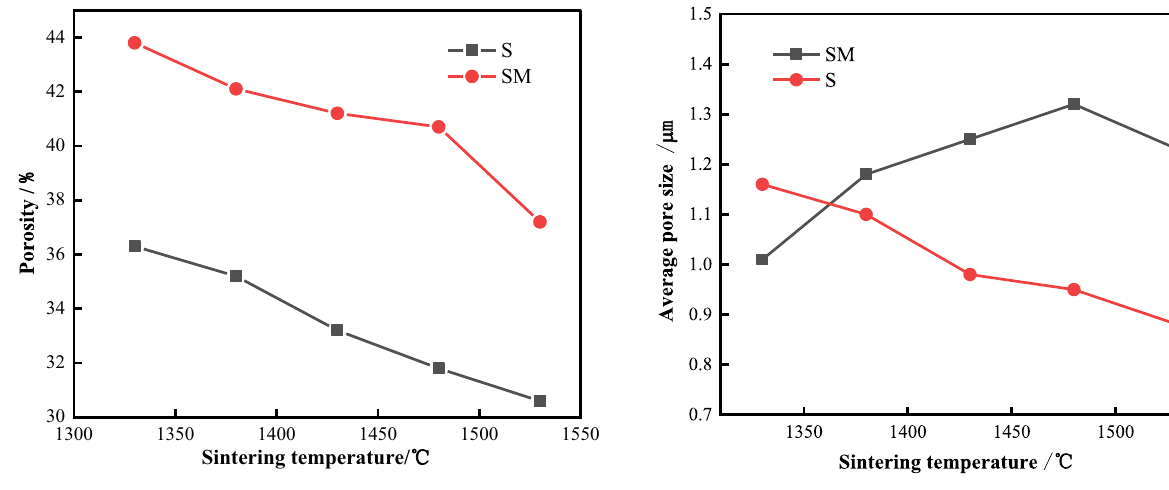
Fig. 7 The average pore size of the support samples sintered at vari- ous temperatures in an air atmosphere for 2